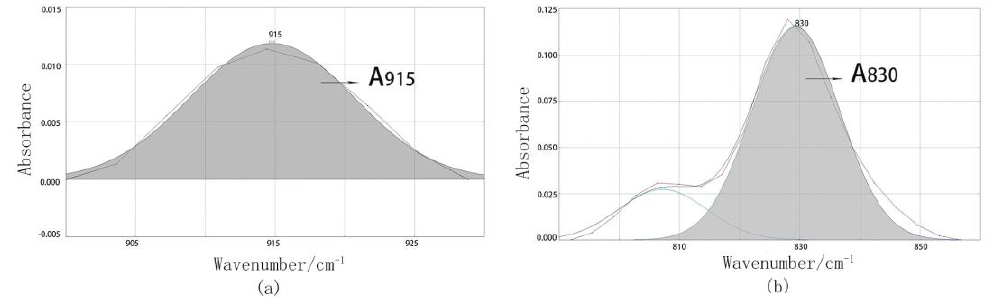
Figure 4. Schematic of the fitting results of the characteristic absorbance peak area: ( a ) wavenumber 915 cm − 1 and ( b ) wavenumber 830 cm − 1 .